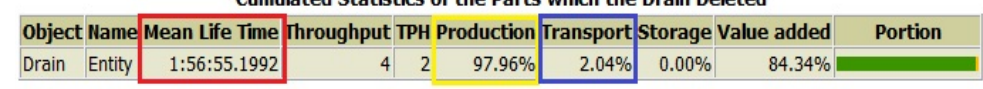
Figure 6. Statistics of the simulated process.